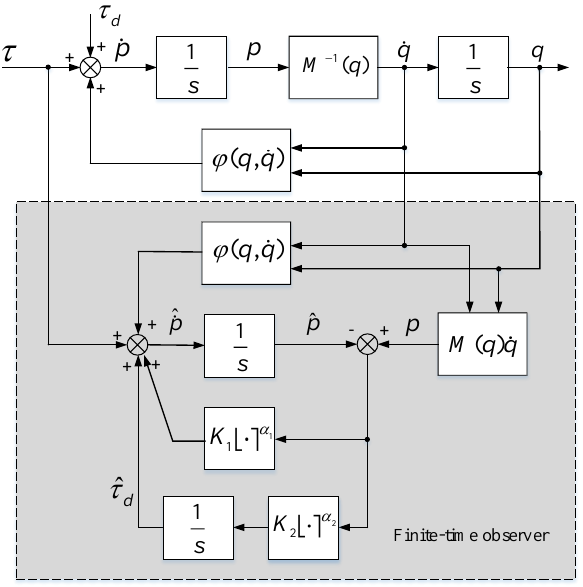
Figure 1. A block diagram of the proposed robotic disturbance finite-time observer